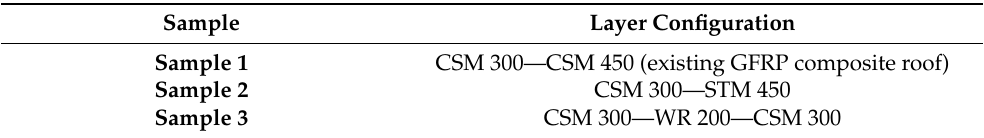
Table 1. Layer configurations of the composite.